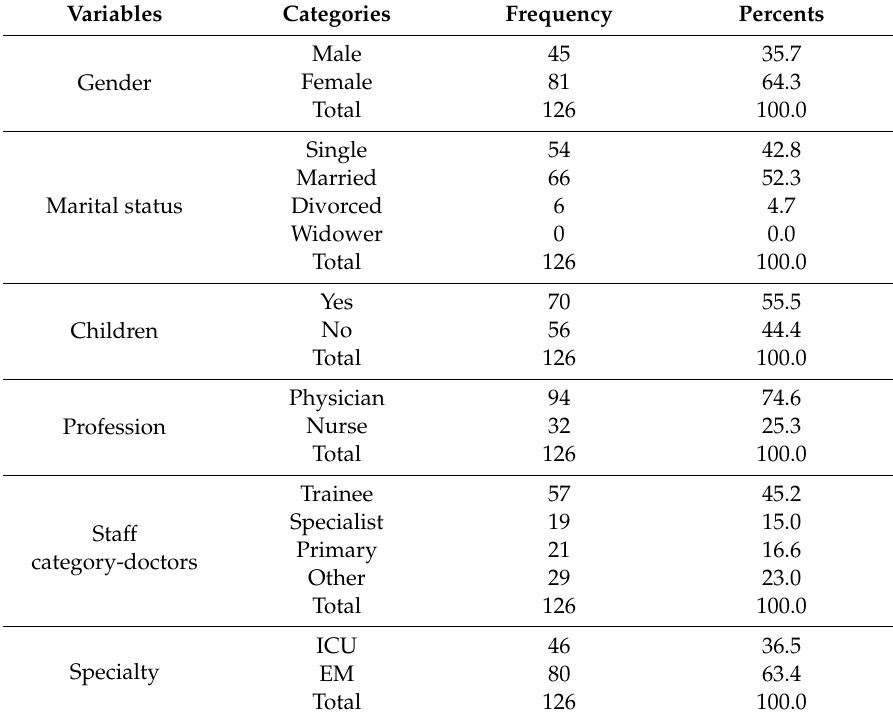
Table 1. Demographic and professional characteristics of frontline healthcare